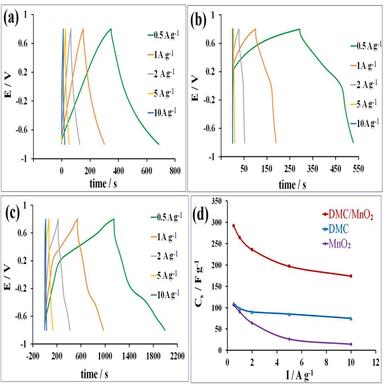
Galvanostatic charge/ discharge curves of (a) DMC, (b) MnO2, (c) DMC/MnO2, and (d) dependence of specific capacitance on the current density.